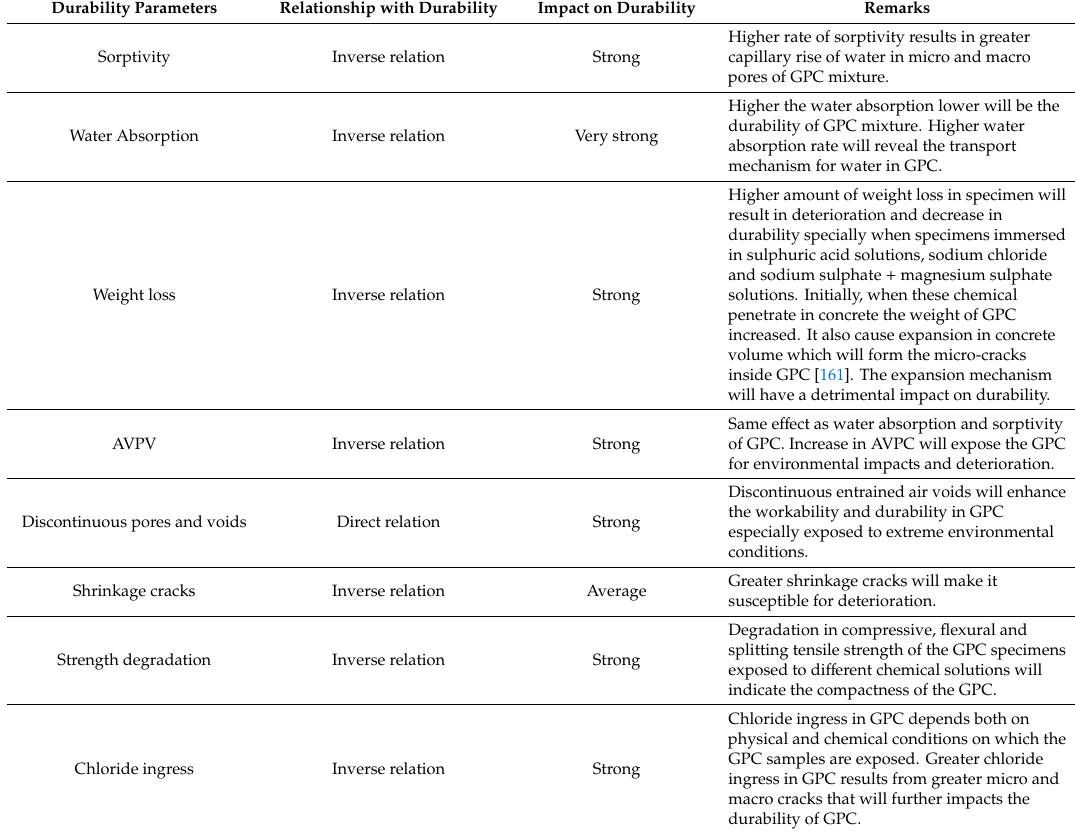
Table 8. Properties e ff ecting the durability of